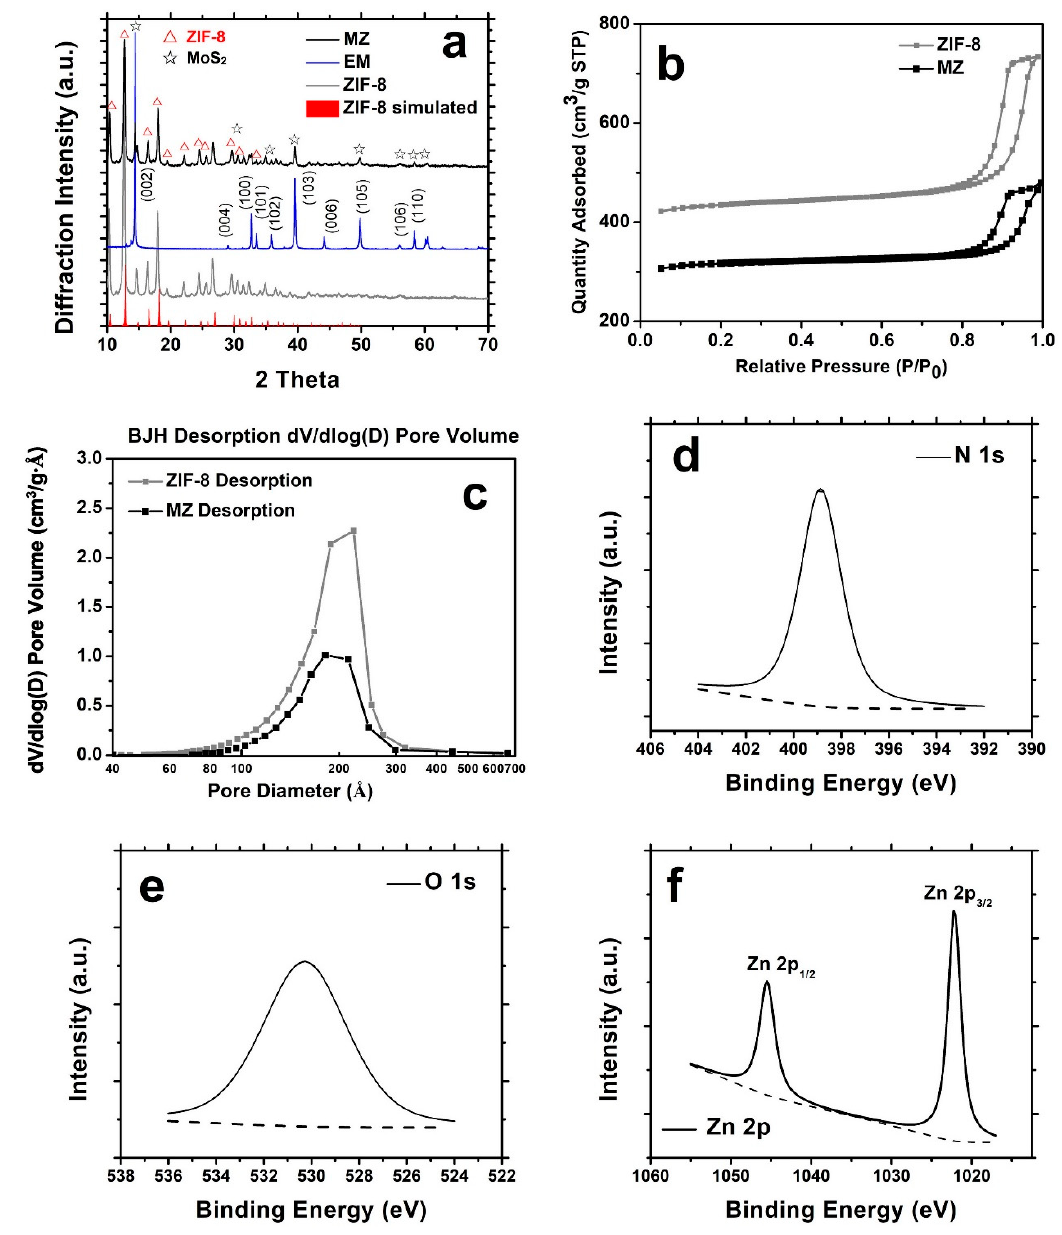
Figure 2. ( a ) Representative XRD patterns of the as-prepared samples; ( b ) N 2 adsorption-desorption isotherms and ( c ) pore size distribution of MZ and zeolitic imidazolate framework (ZIF-8); X-ray photoelectron spectroscopy (XPS) spectrum of ( d ) N1s, € O1s and ( f ) Zn2p of MZ. Table 1. Surface properties of ZIF-8 and as-synthesized MZ .